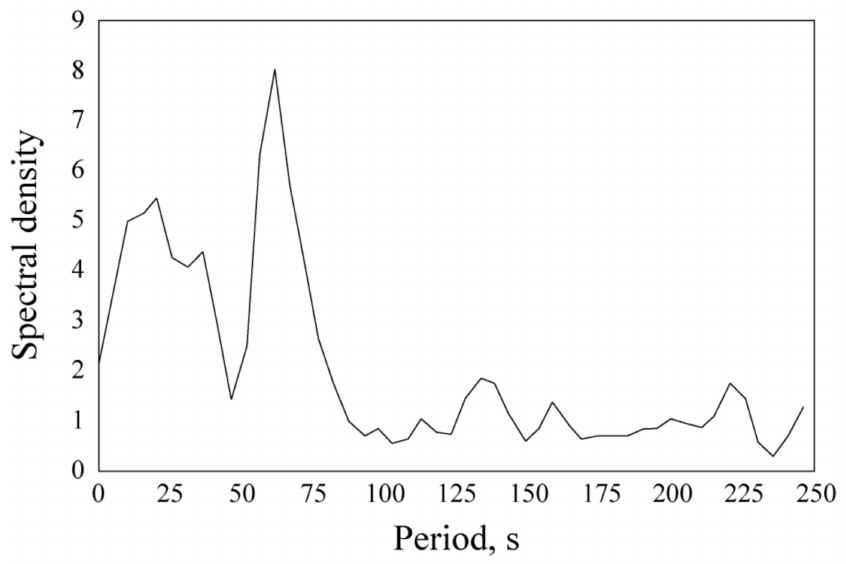
Figure 3. Spectral density of salinity at a depth of 1.5 m at the mooring station located within the Bzyb